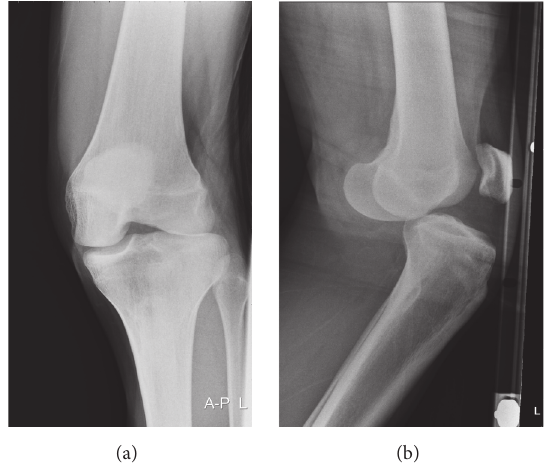
Figure 2: Anteroposterior and lateral radiographs showing anterolateral dislocation of the left knee.